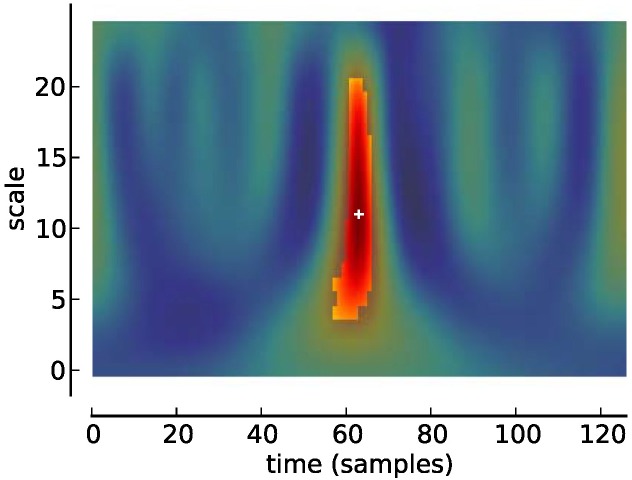
Scalogram of Studentized wavelet coefficients corresponding to Figure 2. Highlighted area indicates location of significant (p < 0.05) differences. Plus sign indicates local maximum.